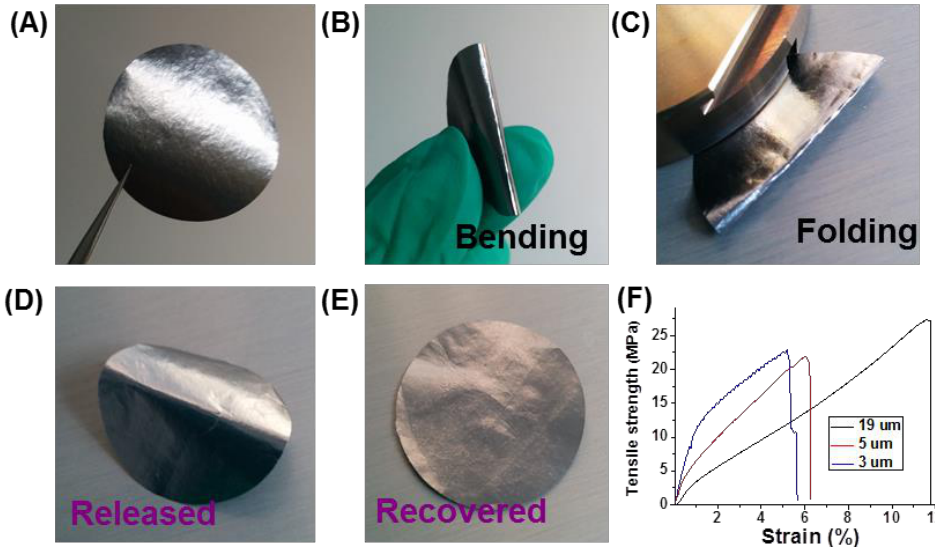
Figure 4. ( A , B ) A compressed GAF with glistening and high flexibility. ( C ) The compressed GAF is folded in half. ( D ) Release of folded compressed GAF, and ( E ) recovery by smoothing. ( F ) Typical mechanical measurements under tensile loading for compressed GAFs with different thicknesses.